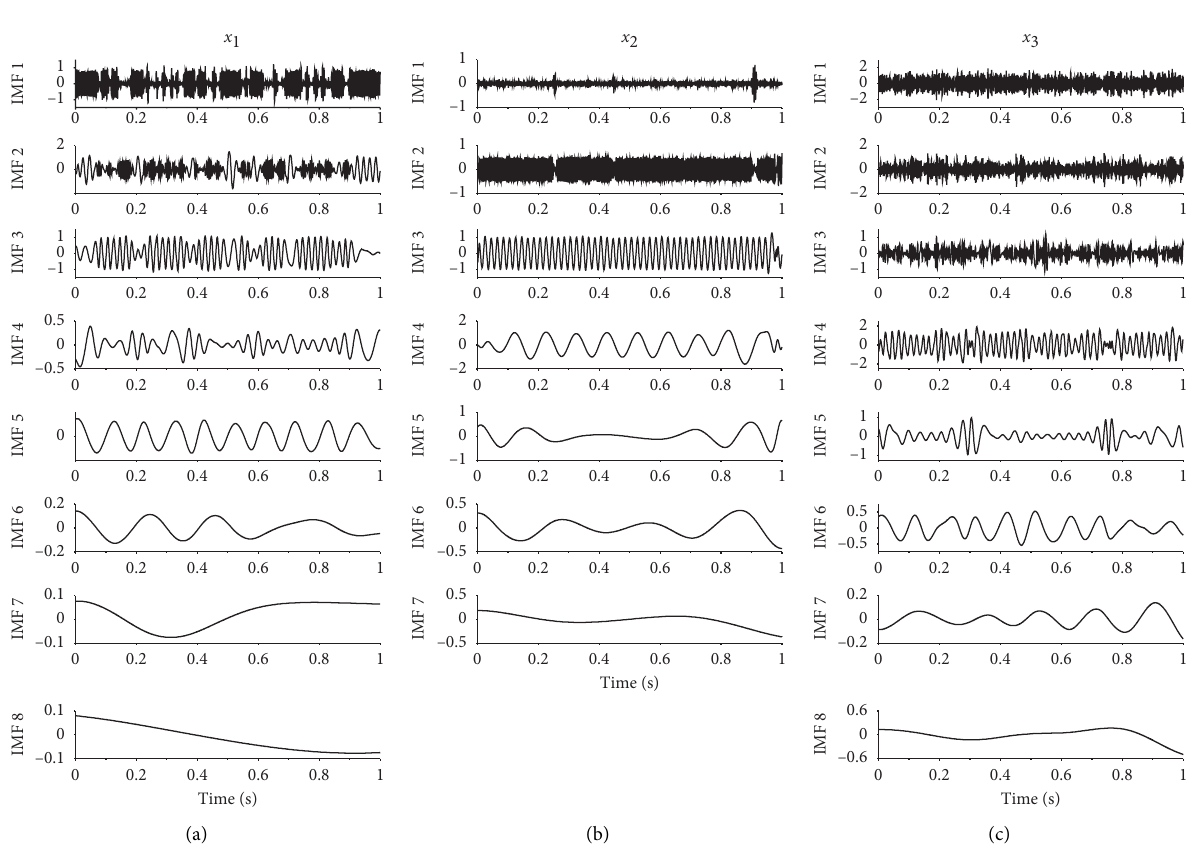
Figure 2: EMD-based decomposition of simulation